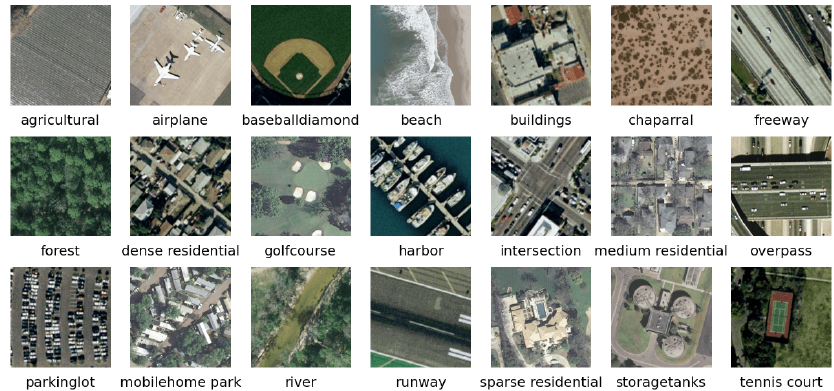
Figure 10. Several images in UCM dataset.